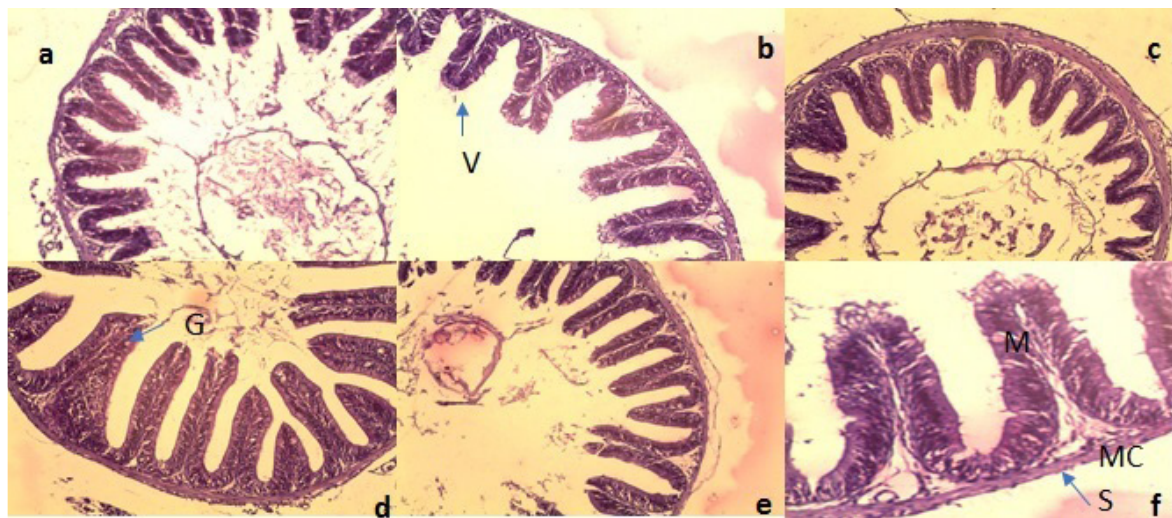
Figure 3 - Photomicrograph of the middle section intestinal of the Nile tilapia post-larvae supplemented with increasing levels of alcoholic extract of propolis. Treatment with 0 g of dry propolis/kg = a ; 1 g/kg = b ; observed villi (V); 2 g/kg = c ; 3 g/kg = d , where goblet cell (G) is observed; 4 g/kg = e . In f , is observed mucosa epithelium (M), muscular tunic (MC) and serous tunic (S). He staining, 10X lens.